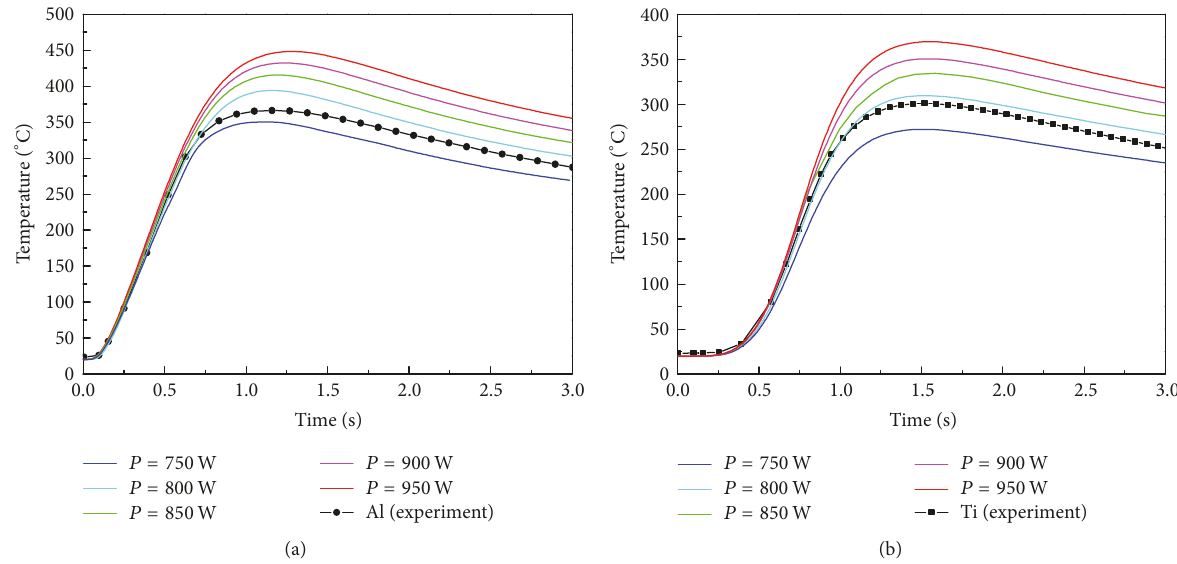
Figure 17: Influence of laser power on the computed temperatures in the nodes corresponding to the thermocouple location on the (a) Al side and (b) Ti side (laser offset of 250 𝜇 m).